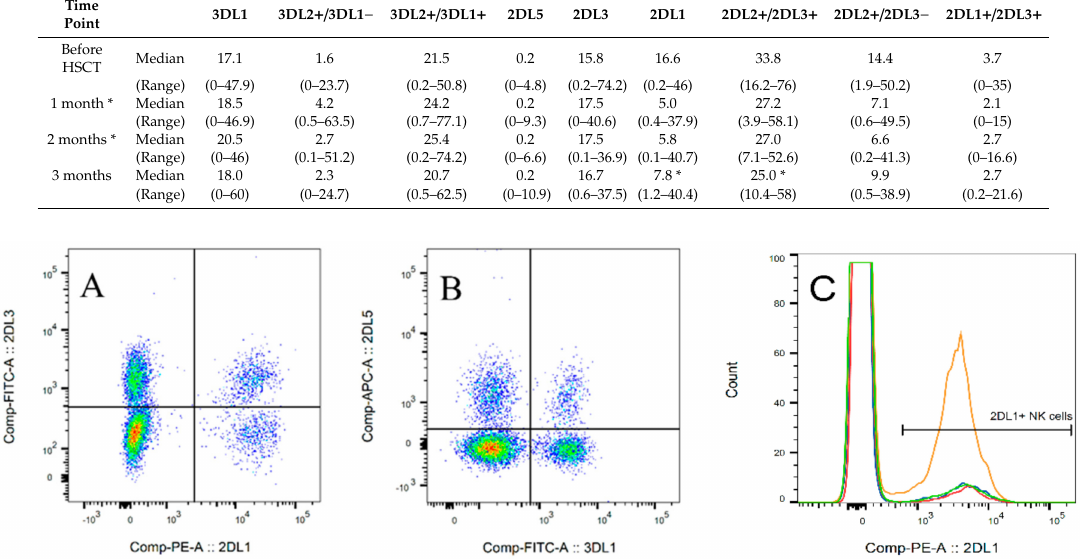
Figure 2. Representative dot-plots and histogram of inhibitory killer-immunoglobulin-like receptor (iKIR) evaluation by flow cytometry. The iKIRs were measured on the surface of NK cells, and the proportion of each iKIR was determined. The expression or coexpression of KIR2DL3 and KIR2DL1 ( A ) and KIR3DL1 and KIR2DL5 ( B ) is shown. The proportion of NK cells positive for KIR2DL1 changed over time ( C ). Orange line = before hematopoietic stem cell transplantation (HSCT); green line = 1 month after HSCT; blue line = 2 months after HSCT; red line = 3 months after